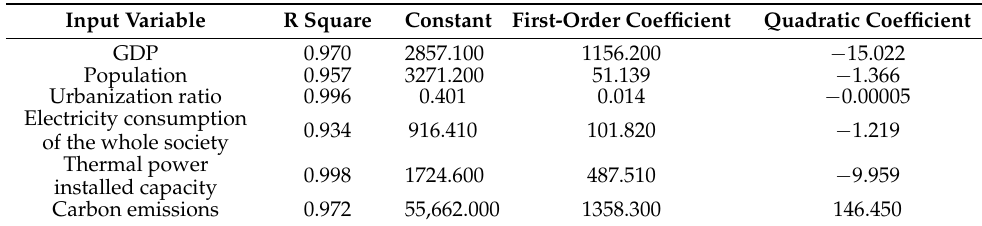
Table 3. Parameter estimation of fitting function for influencing factors of thermal coal demand in Shanxi